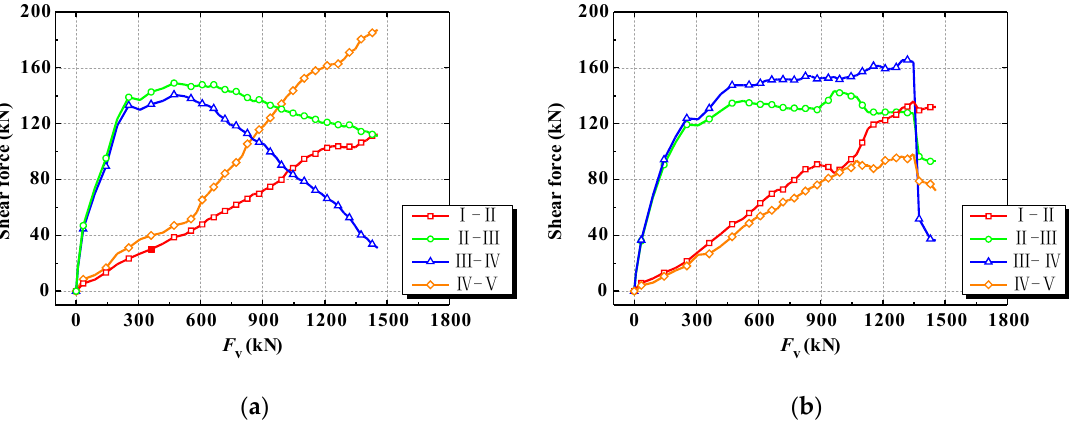
Figure 18. Local shear force between the CFST and the segment. ( a ) Specimen S60C; ( b ) specimen S120C.